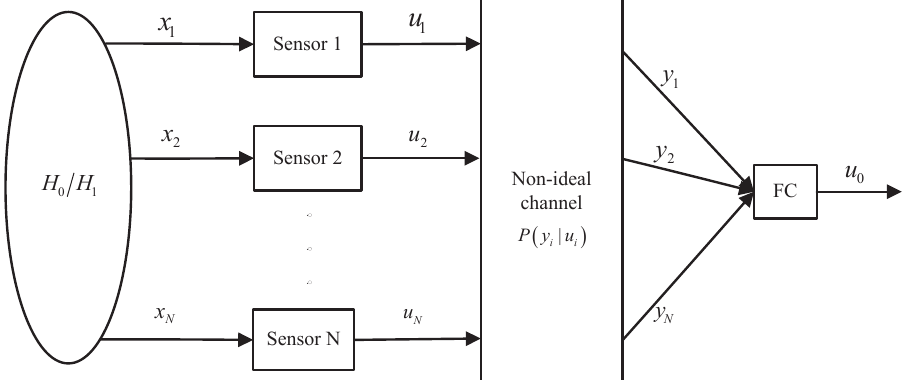
Figure 2. A block diagram of parallel fusion model in the presence of the non-ideal channel characterized by P ( y